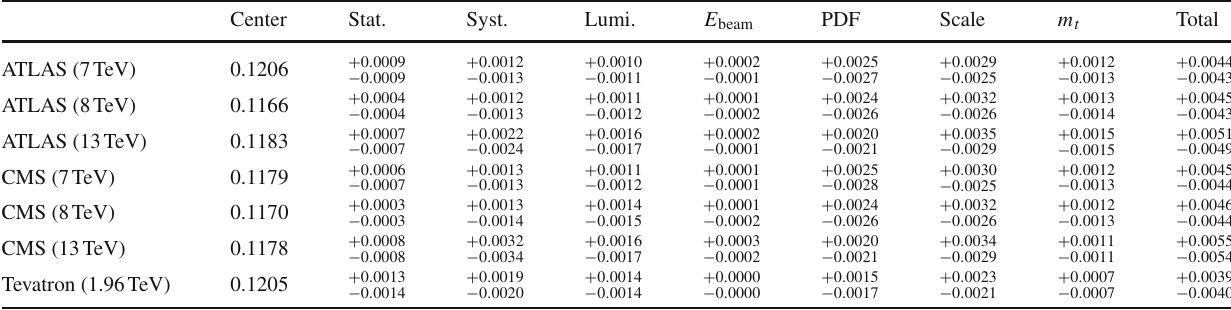
Table 5 As in Table 4, but now using NNLO cross sections with the NNPDF30_nolhc series of PDFs